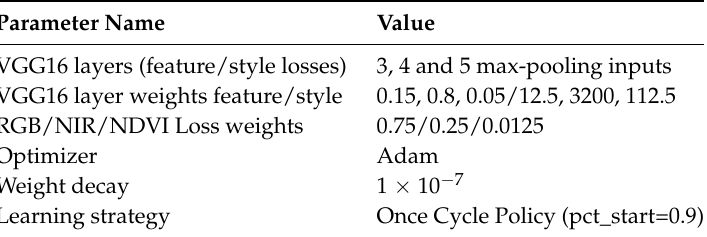
Table 4. Common parameters for all experiments.